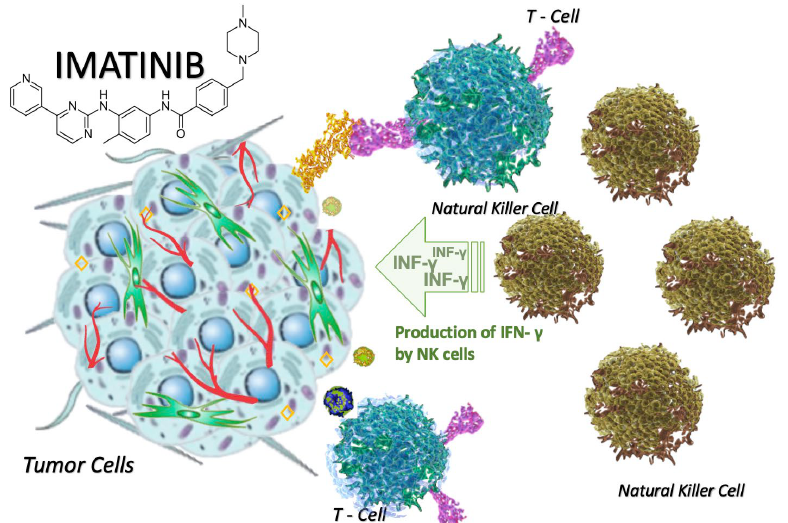
Figure 3. Modification in the tumor microenvironment after the use of imatinib. IM increases the number of NK cells but also supports KIT-dependent crosstalk between DCs and NK cells, resulting in increased production of immune-stimulating IFN- γ. In summary, the inhibition of c-KIT decreases immune-suppressor cells and enhances antitumor immune function [60,61].